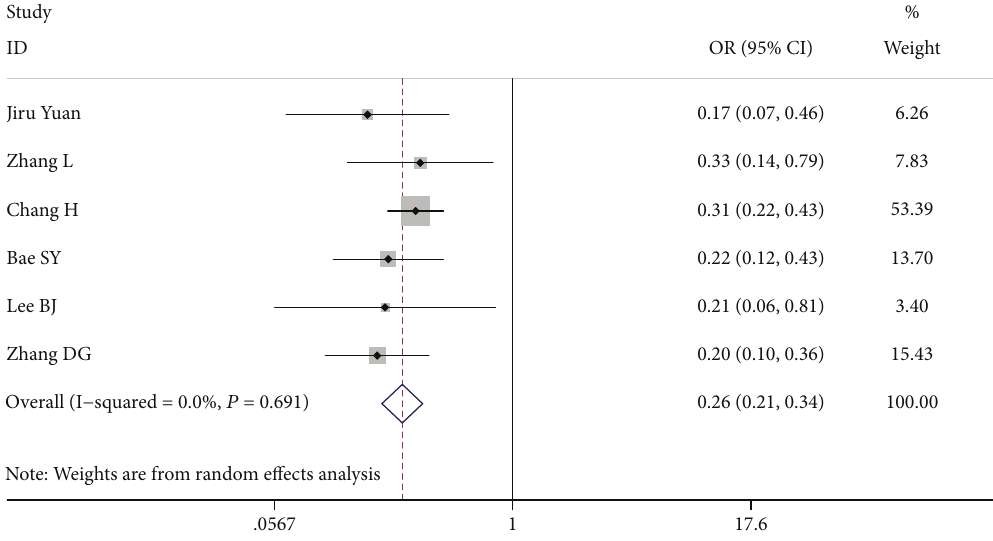
Figure 5: Forest plot for metastasis according to tumour size ≤ 1 cm vs. tumour size > 1cm